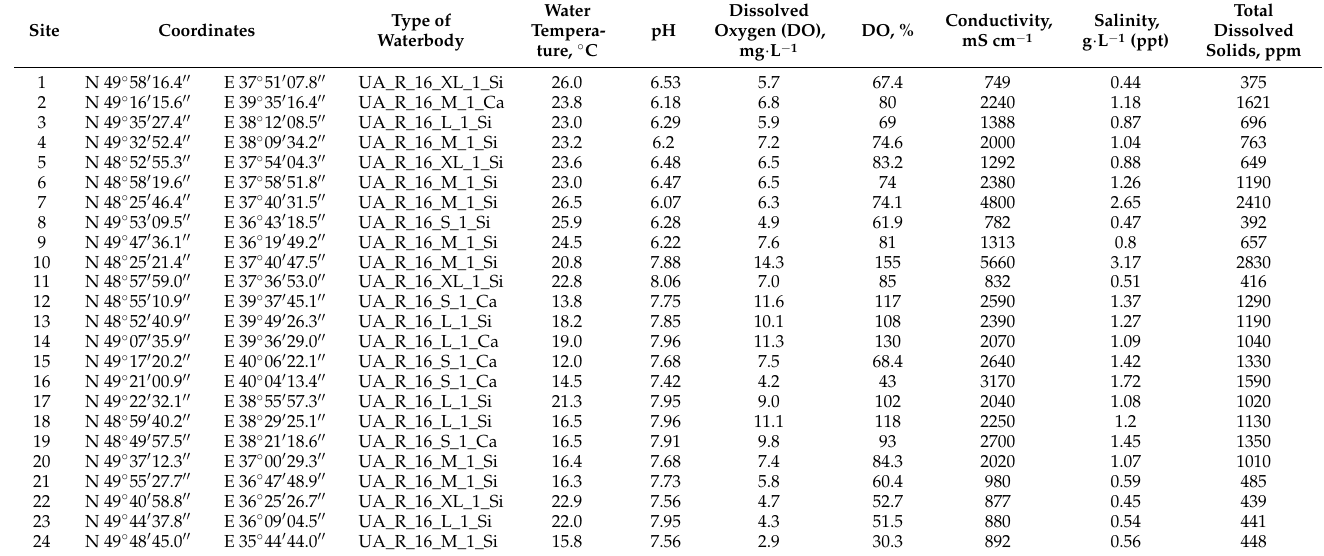
Table 1. The physicochemical parameters of water and GIS coordinates of sampling sites in Siversky Donets river basin (Ukrainian part) in July–August of